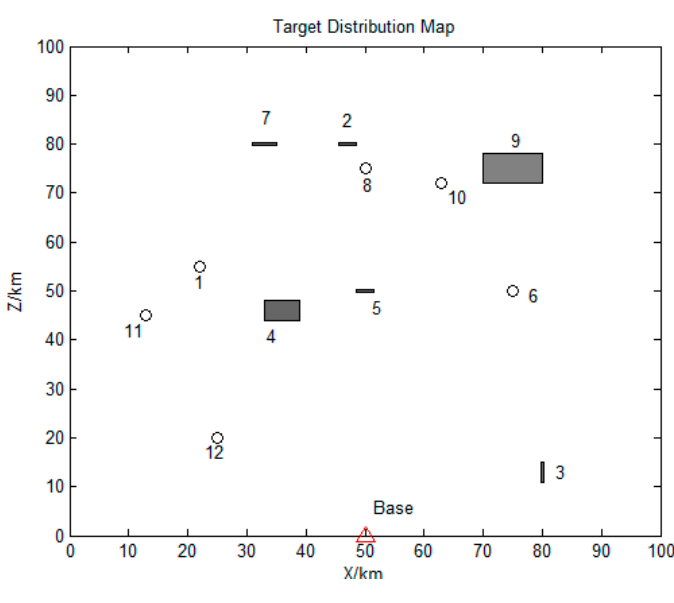
Figure 8. Distribution map of all task points.